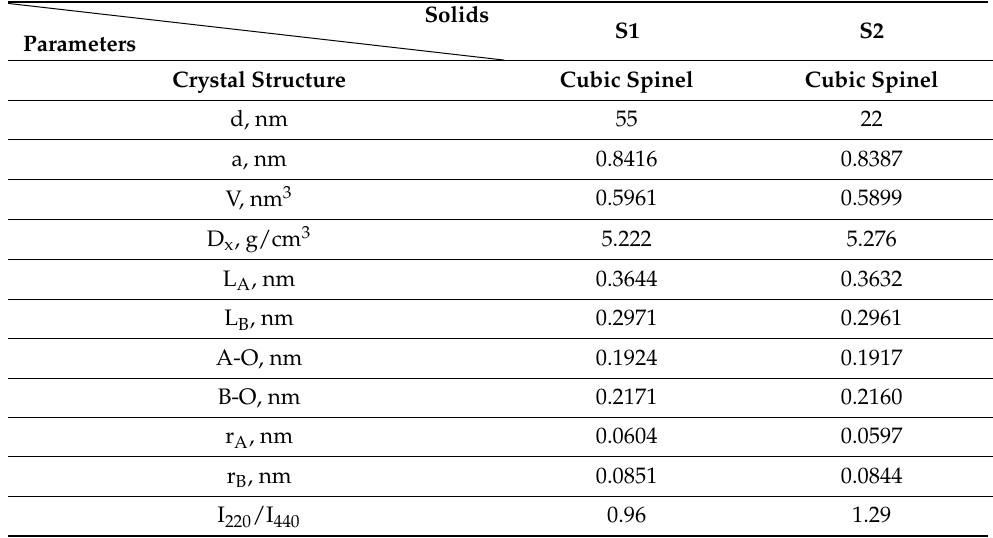
Table 3. Lattice parameters of nanocrystalline NiMn 2 O 4 involved in the as prepared solids.